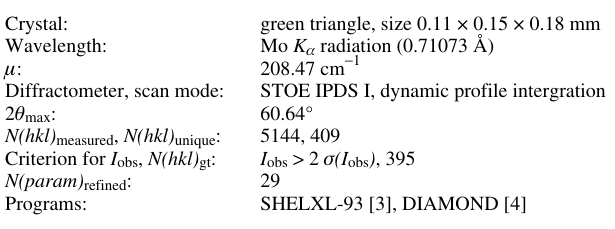
Table 1. Data collection and